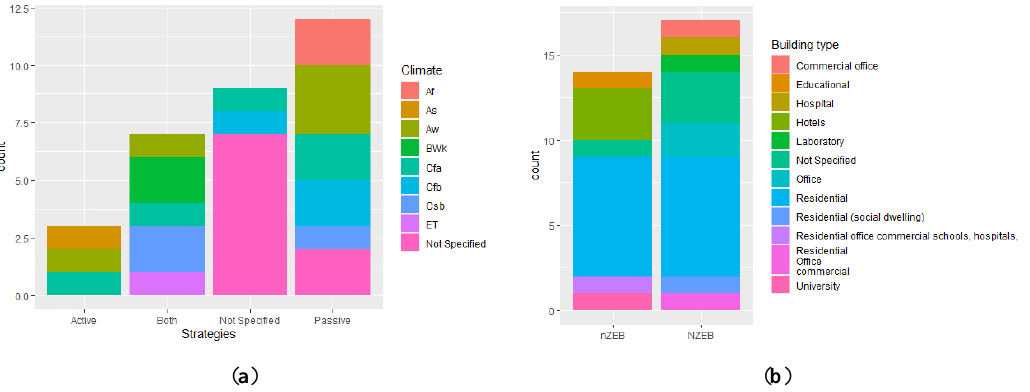
Figure 8. ( a ) Energy strategy according to climate type, and ( b ) building and ZEB type.